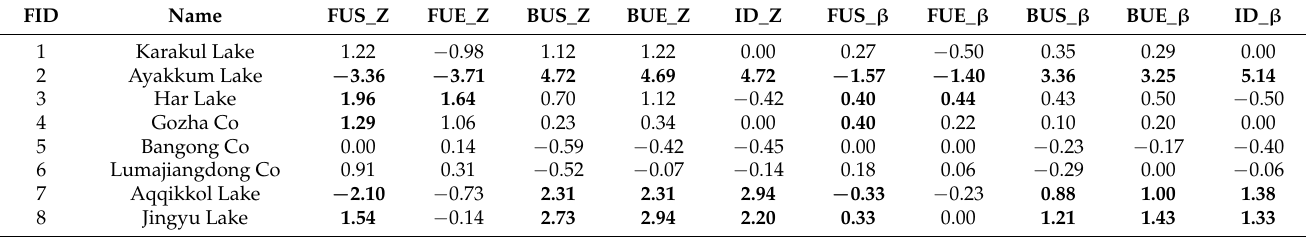
Table 4. Mann–Kendall trend analysis results of lake ice phenological parameters from 2002 to